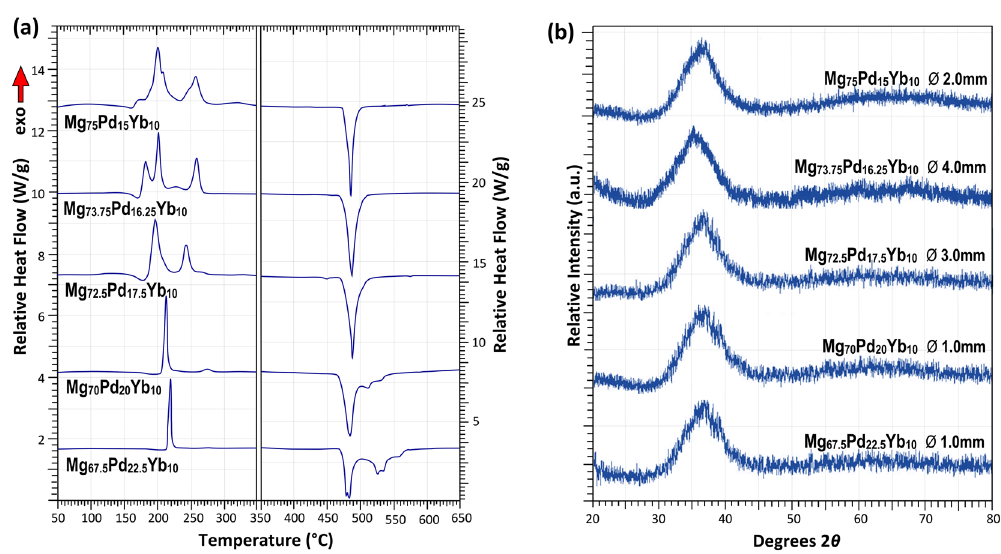
Figure 5. Selected ( a ) DSC and ( b ) XRD traces of Mg–Pd–Yb